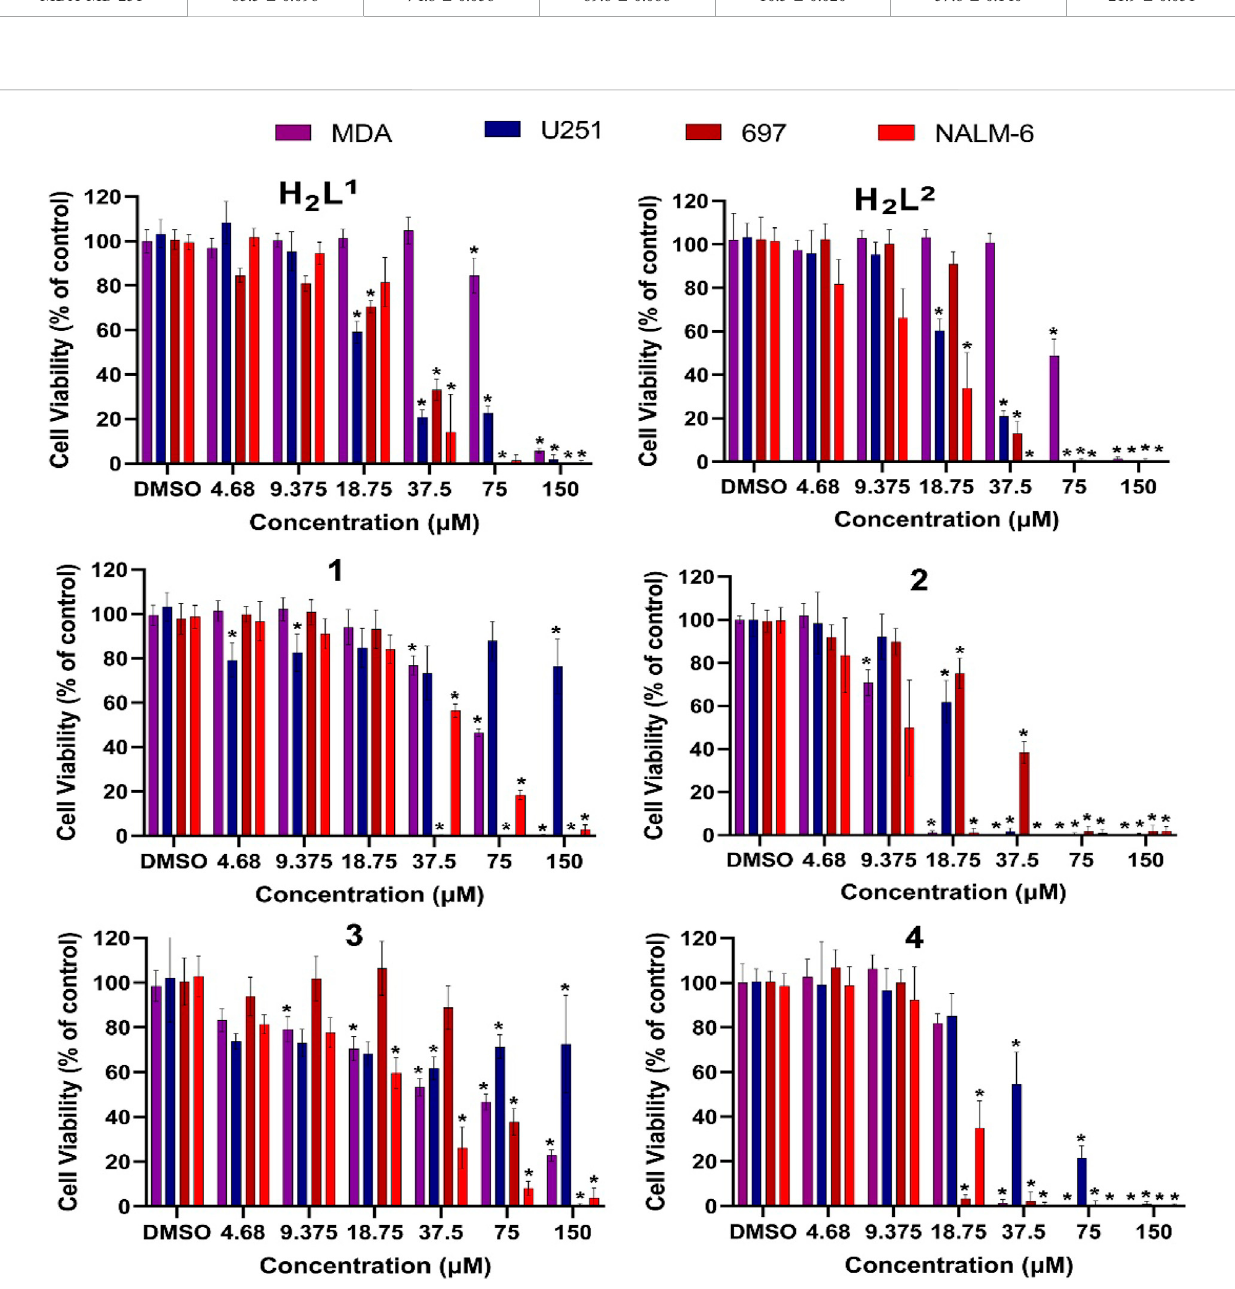
FIGURE 11 Evaluation of cytotoxic effects by MTT/resazurin assay. Concentrations lower than 4.68 µM were deleted since their effects were negligible. The asteriskindicatesthatcellviabilityissigni fi cantlydifferentfromtherespectiveDMSOcontrol( p < 0.5,Kruskal – WallisfollowedbyDunn ’ scomparisontest). DMSO at 0.01% did not affect the cell viability of any cell